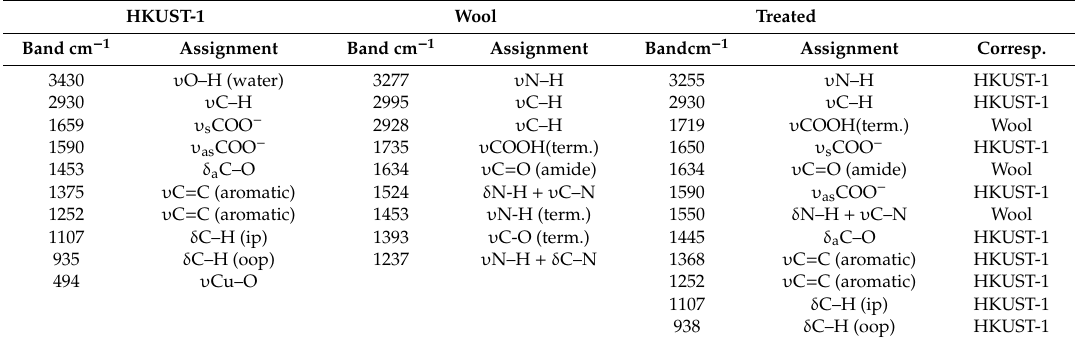
Table 1. FTIR-ATR bands’ assignment for HKUST-1, wool, and treated wool